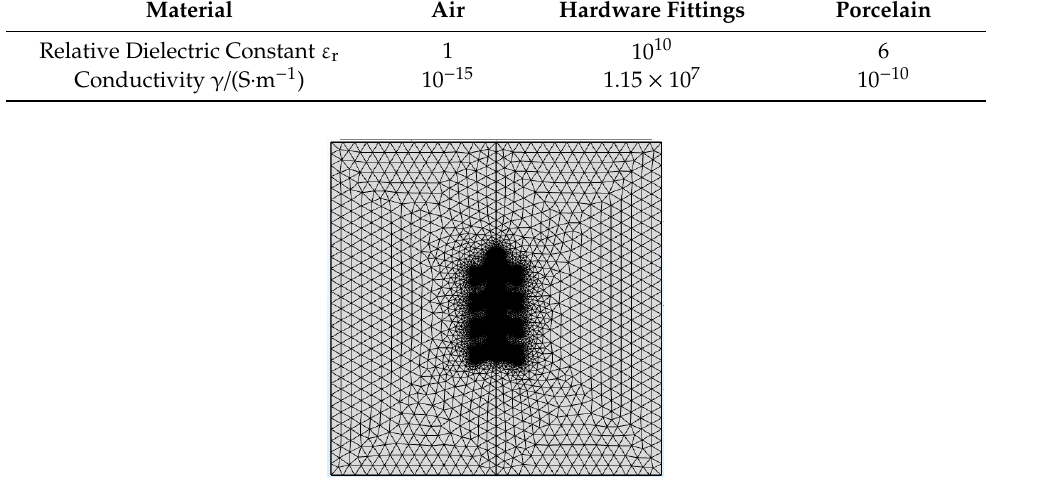
Table 2. Material parameters of U70BL insulator.